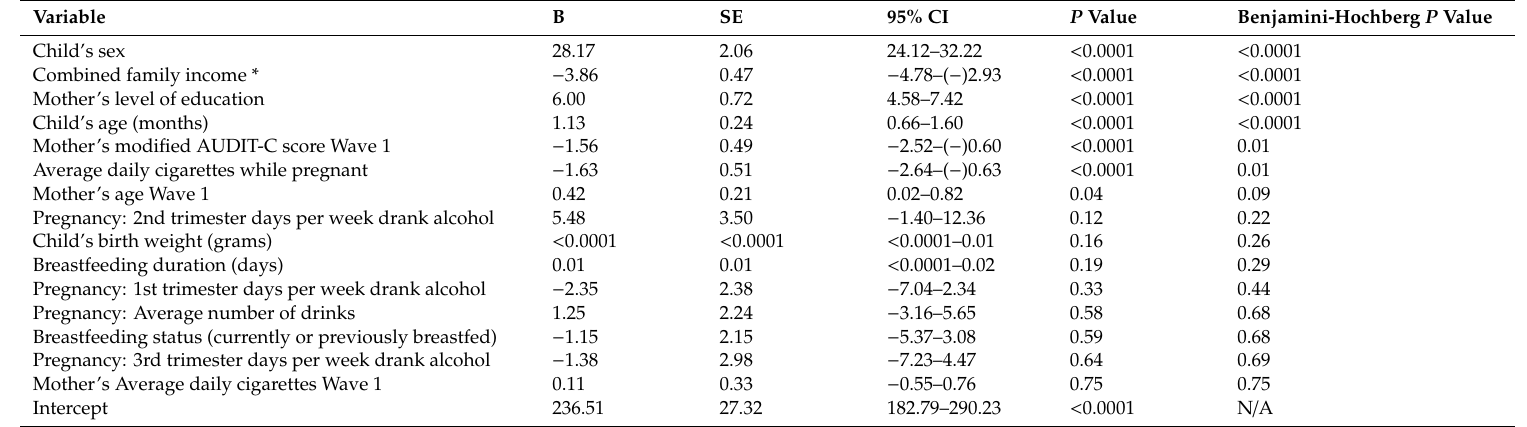
Table 3. Grade 3 NAPLAN writing scores (babies who had been breastfed at any time).